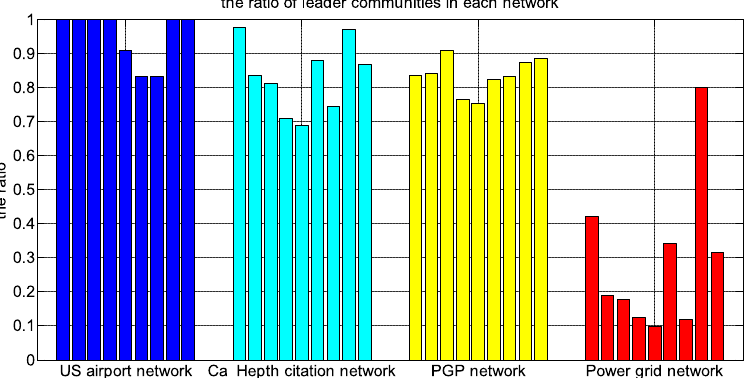
Figure 5. The percentages of leader communities from nine community-finding methods on four real-world networks. Networks are color coded. For each network, nine bars corresponding to nine methods are in the same order as in Fig.